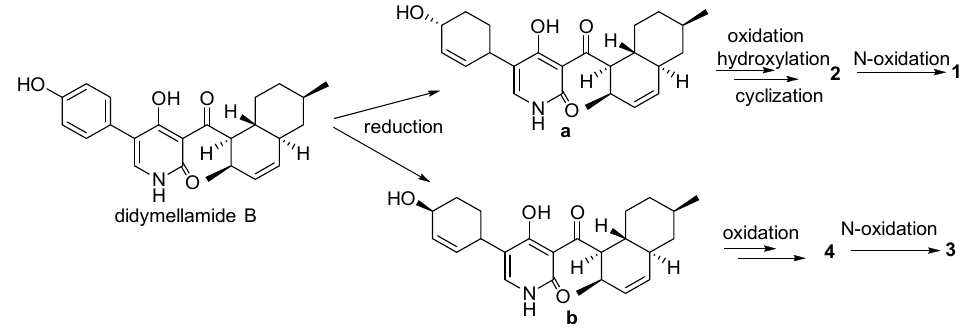
Figure 5. Proposed biosynthetic pathway for compounds 1 - 4.